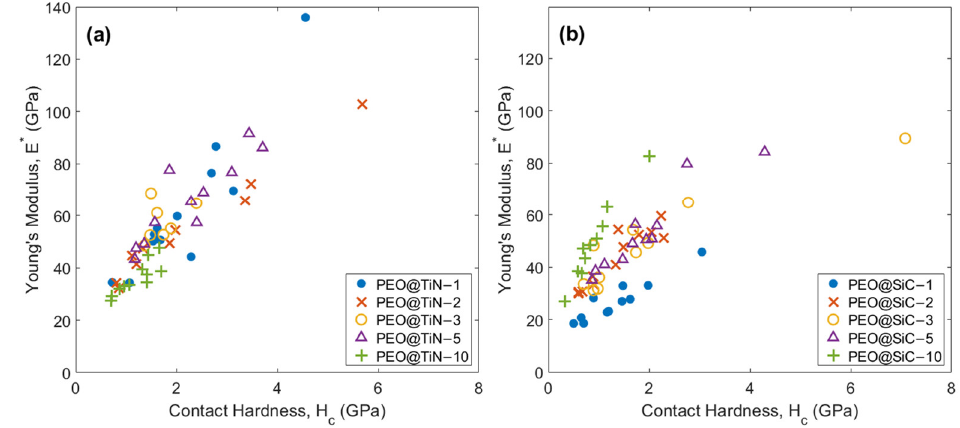
Figure 9. Young’s modulus E * vs. contact hardness H c plots for ( a ) PEO@TiN and ( b ) PEO@SiC coatings.